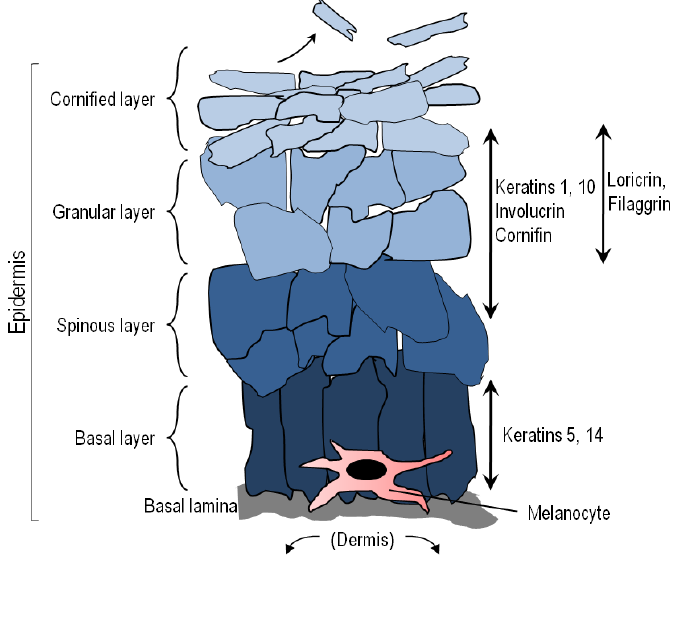
Figure 1. Epidermal structure and keratinocyte differentiation. The epidermis is a self-renewing tissue composed mainly of keratinocytes in various stages of terminal differentiation. Keratinocytes are produced in the stratum basale (basal layer), and move outward through the epidermis, undergoing a programmed series of differentiation involving enucleation and accumulation of cytokeratins and tight junctions with each other. Keratinocytes also receive melanin from melanocytes in the form of pre-packaged organelles termed melanosomes. The basic layers from the basement membrane outward are the stratum basale, stratum spinosum, stratum granulosum, and the stratum corneum, each identified by the morphology and differentiation state of the keratinocyte as indicated by expression of cytokeratins and other